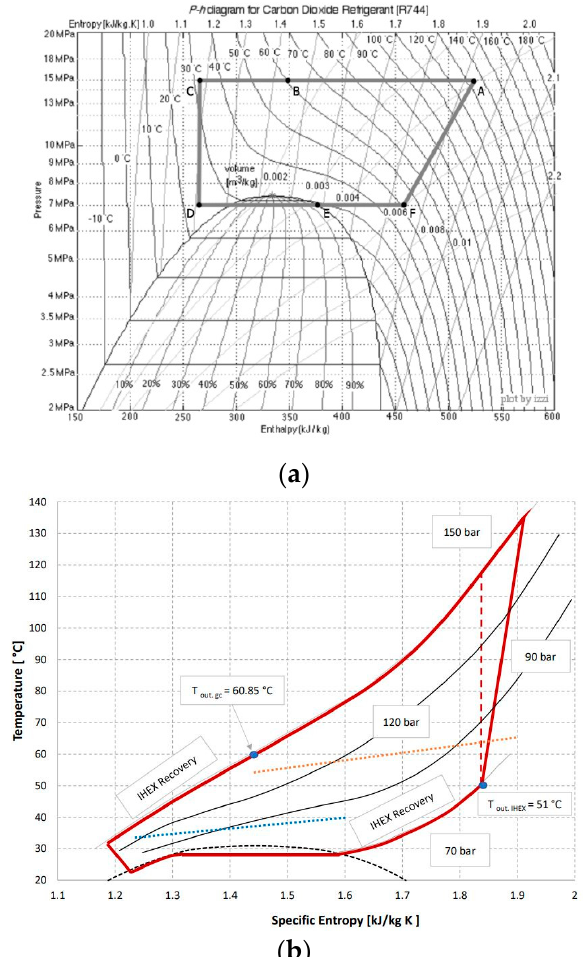
Figure 5. ( a ) P-h diagram carbon dioxide refrigerant [R744] and ( b ) T-S diagram (A: Inlet gas cooler; B: Inlet internal heat exchanger; C: Throttle valve; D: Inlet evaporator; E: Inlet internal heat exchanger; F: Inlet compressor).